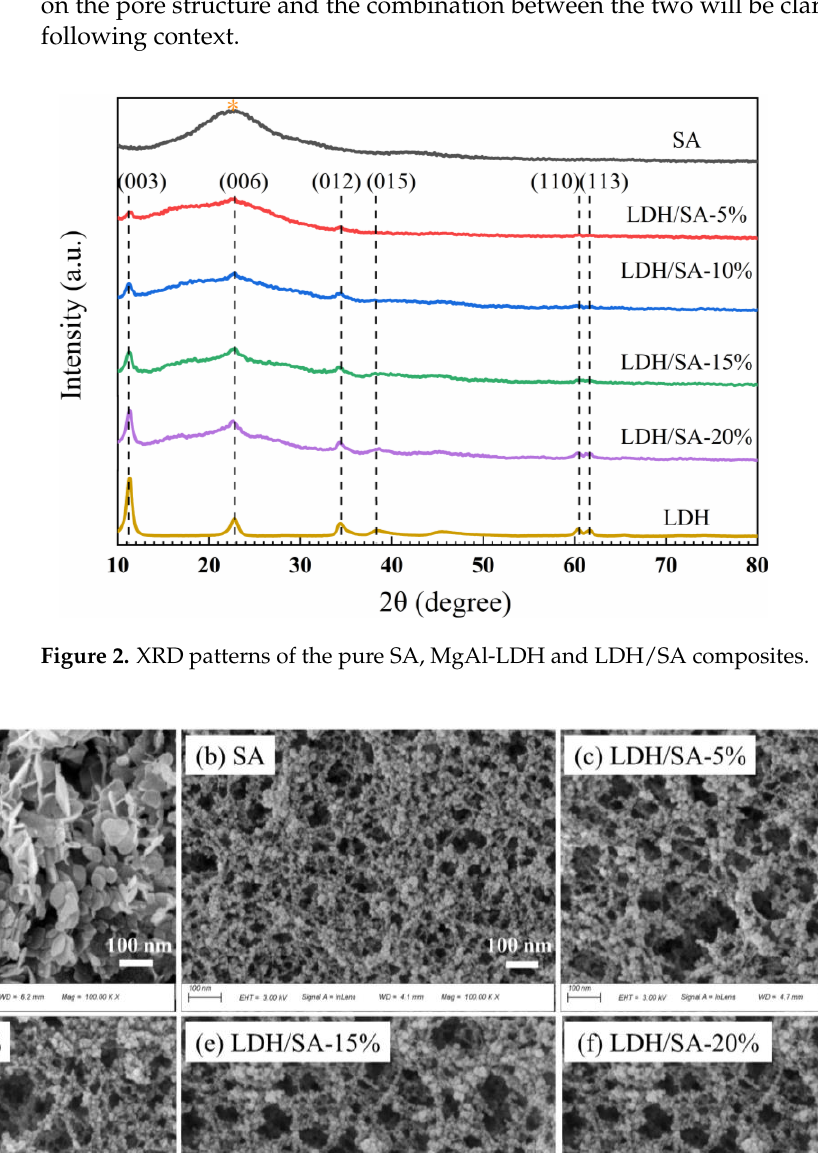
Figure 4. EDS spectra of the LDH/SA-5% ( a ) and LDH/SA-20% ( b ). 2.3. Pore Structure The N 2 adsorption – desorption isotherms are used to investigate the pore structure further. It can be seen that SA and LDH/SA composites have similar N 2 adsorption – de- sorption isotherms in Figure 5. According to the IUPAC classification [26], all these N 2 adsorption – desorption isotherms conform to the type IV isotherm, corresponding to the characteristic of mesoporous materials. The hysteresis loops of type H3 indicate the pres- ence of slit-like interparticle pores [27]. Hence, the introduction of MgAl-LDH does not change the mesoporous attribution of the LDH/SA composites significantly. The Barrett – Joyner – Halenda (BJH) method used to measure the pore size distribu- tion has some limitations [28,29]. The BJH method is characterized in the range of 1.7 – 300 nm and is suitable for mesoporous materials of 2 – 50 nm. We believe that the introduction of LDH leads to the collapse of the porous network of the aerogel, which increases the